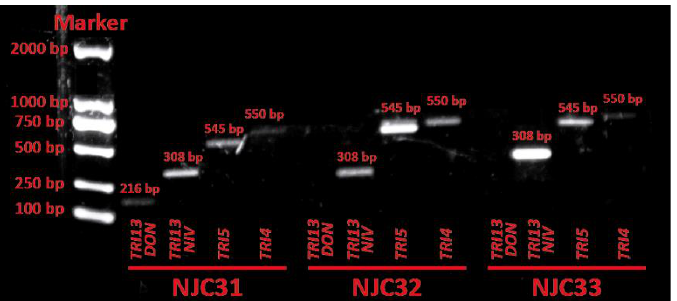
Figure 5. Electrophoresis analysis of trichothecene biosynthetic genes TRI13DON , TRI13NIV , TRI5